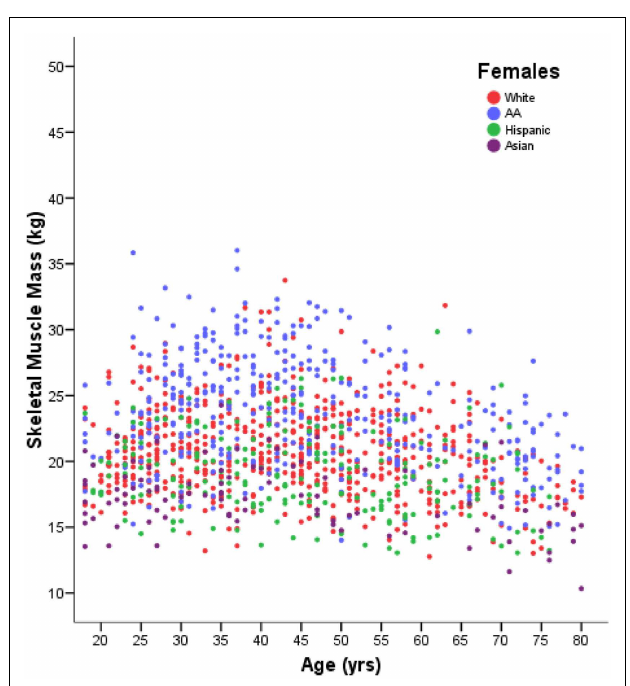
FIGURE 1 | Muscle mass in 1280 females aged 18–80years, measured by DXA. With permission Z. M.Wang and A. M. Silva, adapted from Silva et al. (2009).